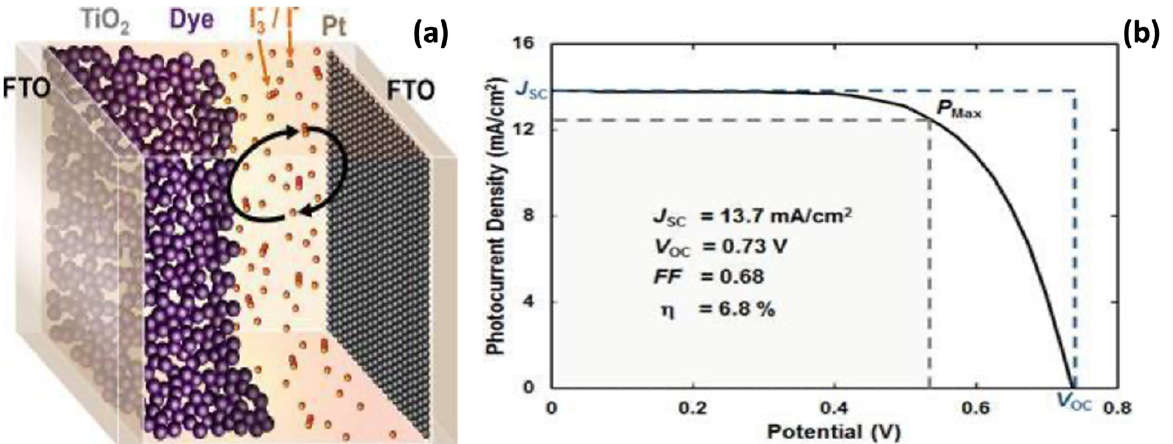
Figure 31. ( a ) Design of solar cell, ( b ) A sample DSSC J-V curve obtained under 1000 W/m 2 AM1. %G solar simulation. The J sc , V oc, and P max points are highlighted and solar cell characteristics tabulated under the curve. The FF can be determined as the ratio of the area enclosed by the gray dotted lines to the area enclosed by the blue dotted lines. Figure 31 reprinted with permission from [139]. Copyright @ 2020 American Chemical Society.